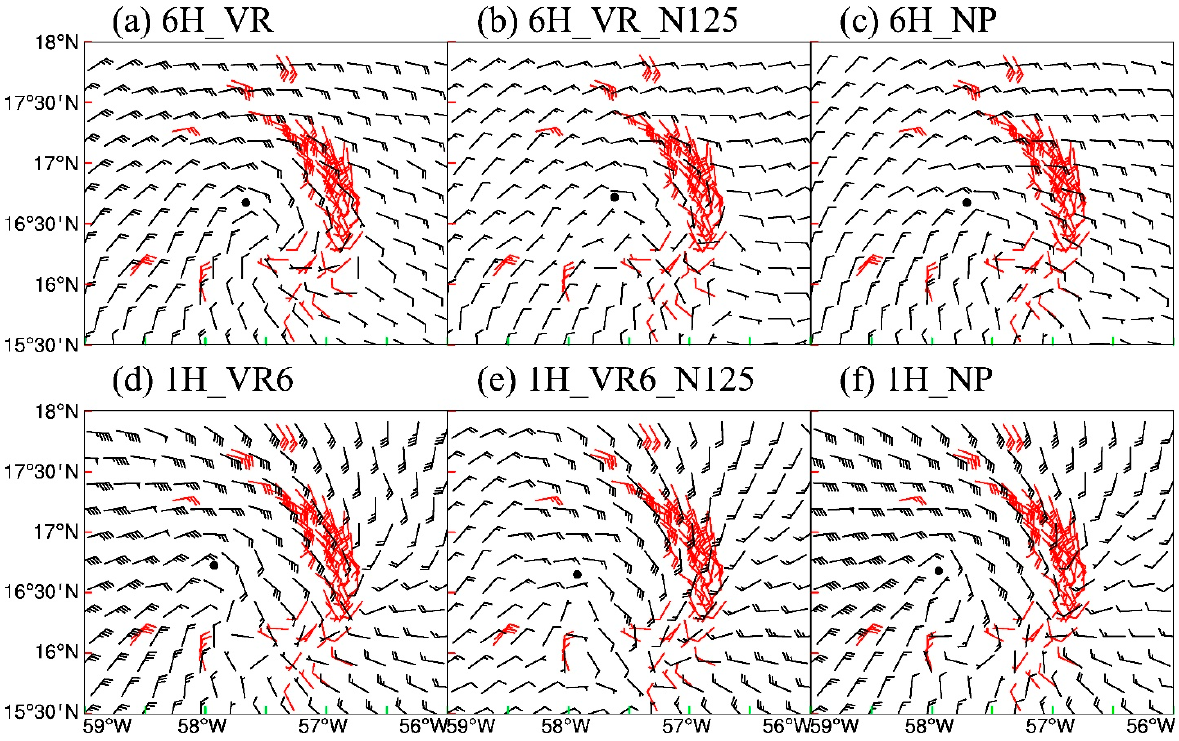
Figure 7. The 100 hPa horizontal wind flow (black) in verification with the AMVs (red; between 90hPa and 110 hPa) for ( a ) “6H_VR”, ( b ) “6H_VR_N125”, ( c ) “6H_NP”, ( d ) “1H_VR6”, ( e ) “1H_VR6_N125”, and ( f ) “1H_NP” valid at 12:00 UTC, 5 September 2017. The black dot indicates the analysis storm center from the surface for each experiment.